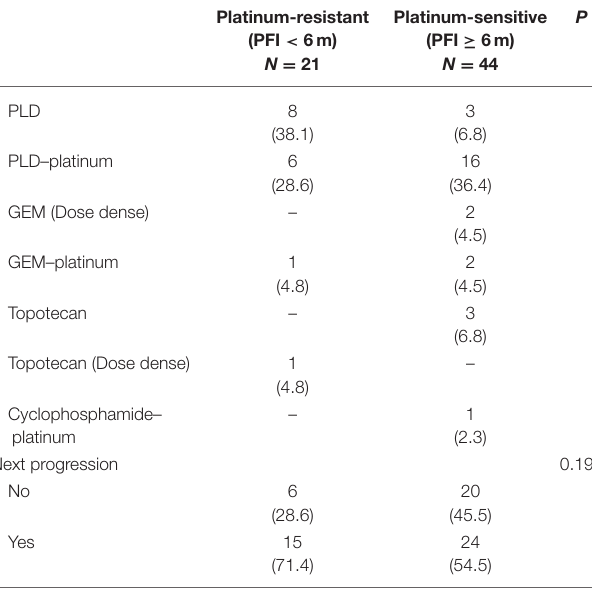
TABLE 2 | Clinico-pathological characteristics of patients with recurrent or persistent disease (Cohort 2) ( N =